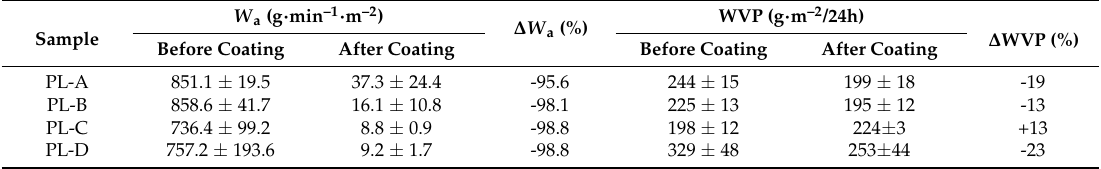
Table 4. The water absorption amounts by contact sponge ( W a ) and the water vapour permeability values (WVP) along with the standard deviation and percentage of variation ( ∆ W a , % and ∆ WVP, %) measured on the PL samples before and after the spray coating with 0.02 M TiO 2 NRs n-heptane dispersion for different